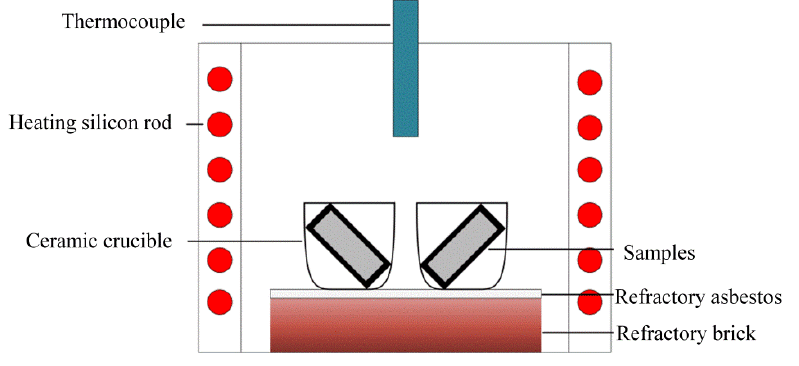
Figure 3. Schematic diagram of the static oxidation experiment apparatus.